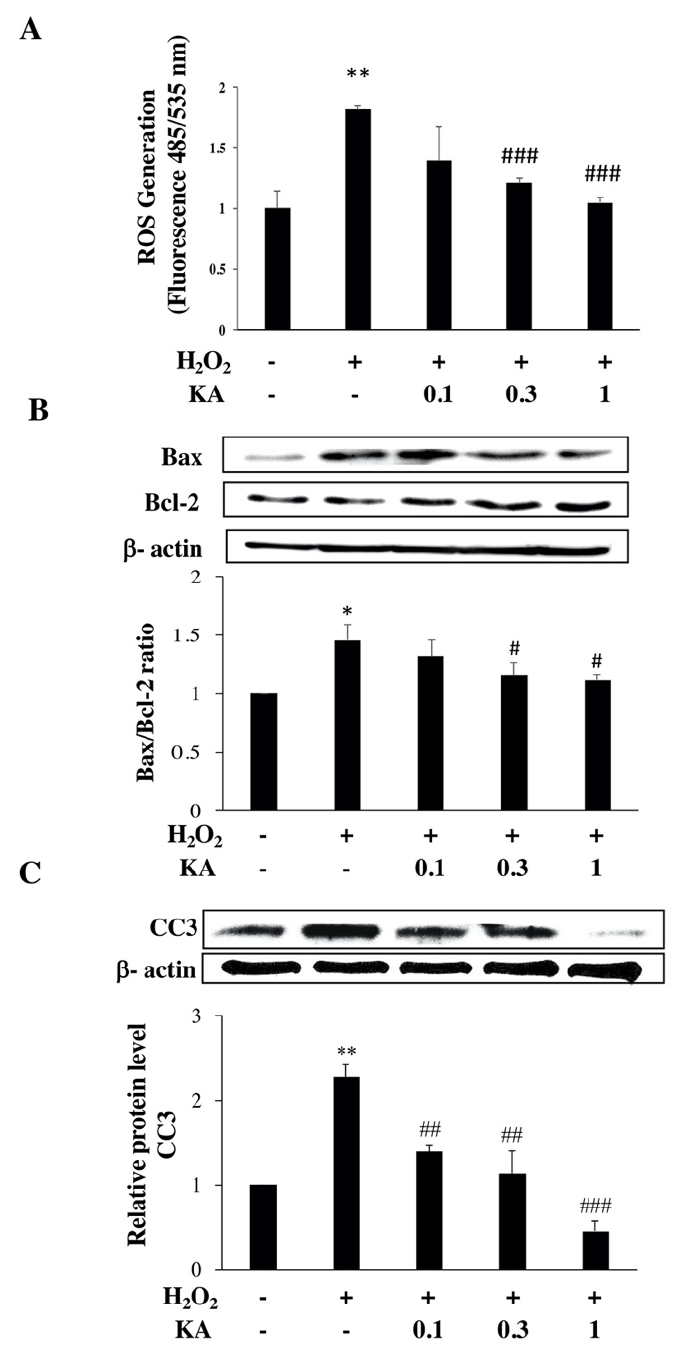
Figure 2. Effects of Kansuinine A (KA) on hydrogen peroxide (H 2 O 2 )-induced reactive oxygen species (ROS) generation, the Bax/Bcl-2 ratio, and cleaved caspase-3 (CC3) protein expression in human aortic endothelial cells (HAECs). HAECs were exposed to KA (0.1, 0.3, and 1.0 µ M) for 1 h before H 2 O 2 (200 µ M) treatment for 24 h. ( A ) The cellular ROS/superoxide detection assay was performed. ( B ) Bax/Bcl-2 ratio. ( C ) CC3 expression was evaluated using western blotting. β -actin was used as an internal control. Data are presented as means ± standard deviation (n = 3). p Values were determined using the Student’s t -test. * p < 0.05, ** p < 0.01 vs. control group; # p < 0.05, ## p < 0.01, ### p < 0.001 vs. H 2 O 2 group CC3, Cleaved caspase-3.